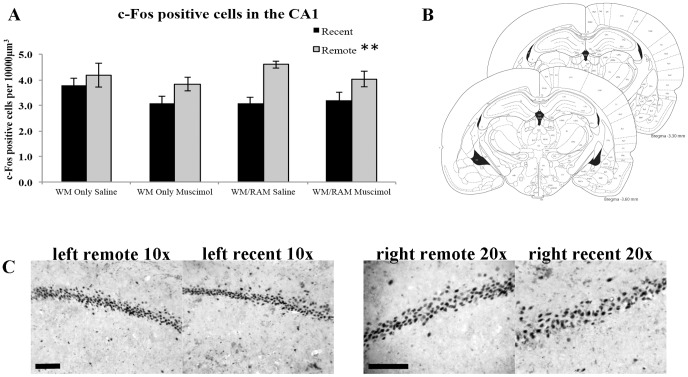
c-Fos positive cells in the CA1 of the hippocampus.A) Quantification of the number of c-Fos positive cells per 10000 µm3 in the CA1 of the hippocampus. Remotely probed rats displayed greater numbers of c-Fos positive cells than recently probed rats. B) Depiction of the CA1 area where c-Fos immunoreactive cells were counted (Paxinos & Watson, 1998). C) Representative images of c-Fos staining in the CA1 region in the left hemisphere at 10× and the right hemisphere at 20× magnification. Scale bar at both magnifications  = 100 µm. **Indicates a main effect of time (remote> recent).